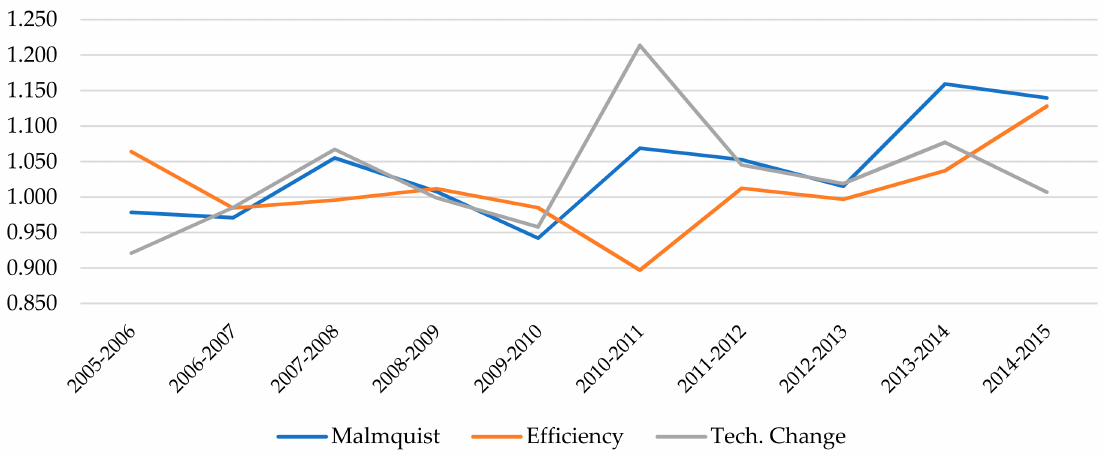
Figure 1. Evolution of the Malmquist Index and its main components